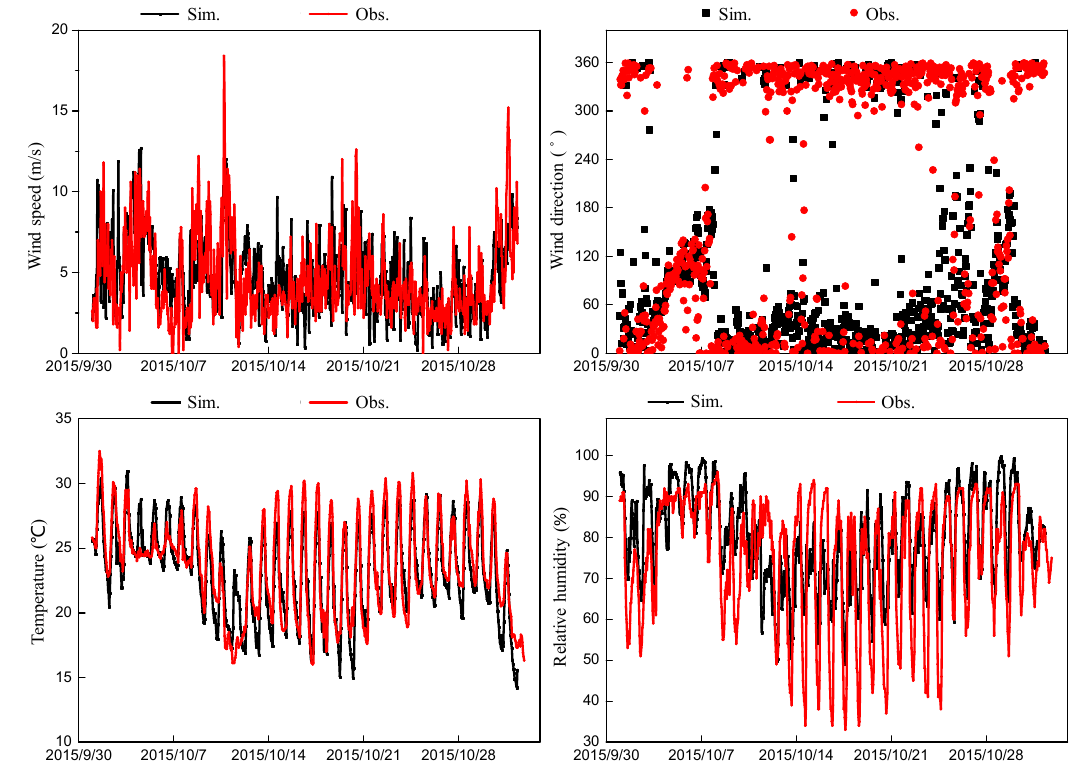
Figure 4. Comparison of simulated and observed meteorological parameters in Guangzhou, 2015. (Hourly statistical data in October